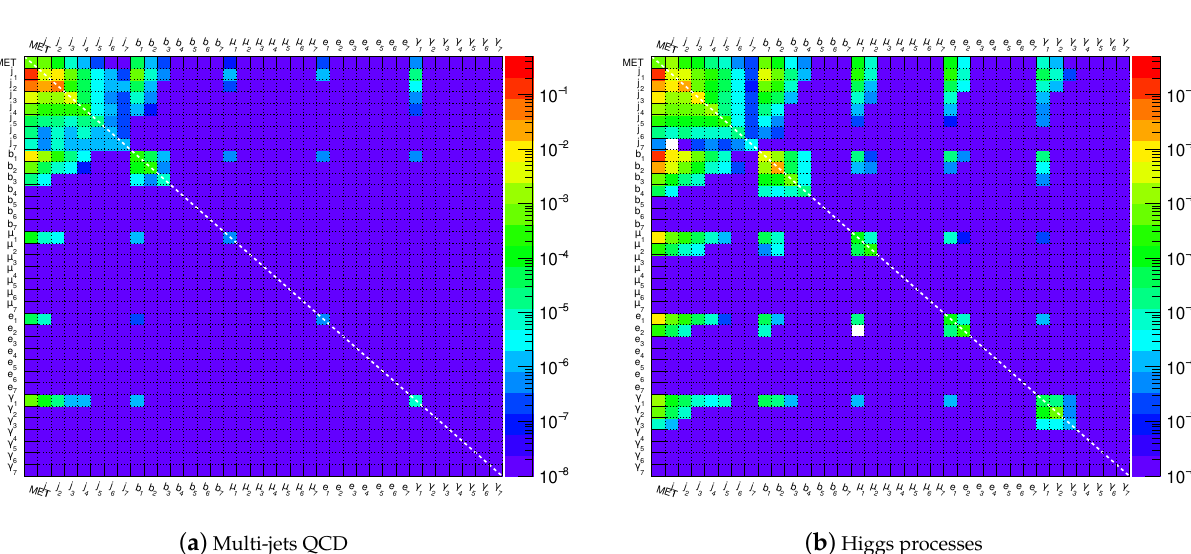
Figure 1. Visualization of the rapidity–mass matrixes (RMMs) for ( a ) multijet QCD events and ( b ) for the Standard Model Higgs production (all decays of the Higgs are allowed). The definition of the RMM is given in the text. The RMMs were obtained after averaging over 100,000 pp collision events generated using Pythia8 after parton showers and hadronization. The several empty cells shown in white color are due to the lack of